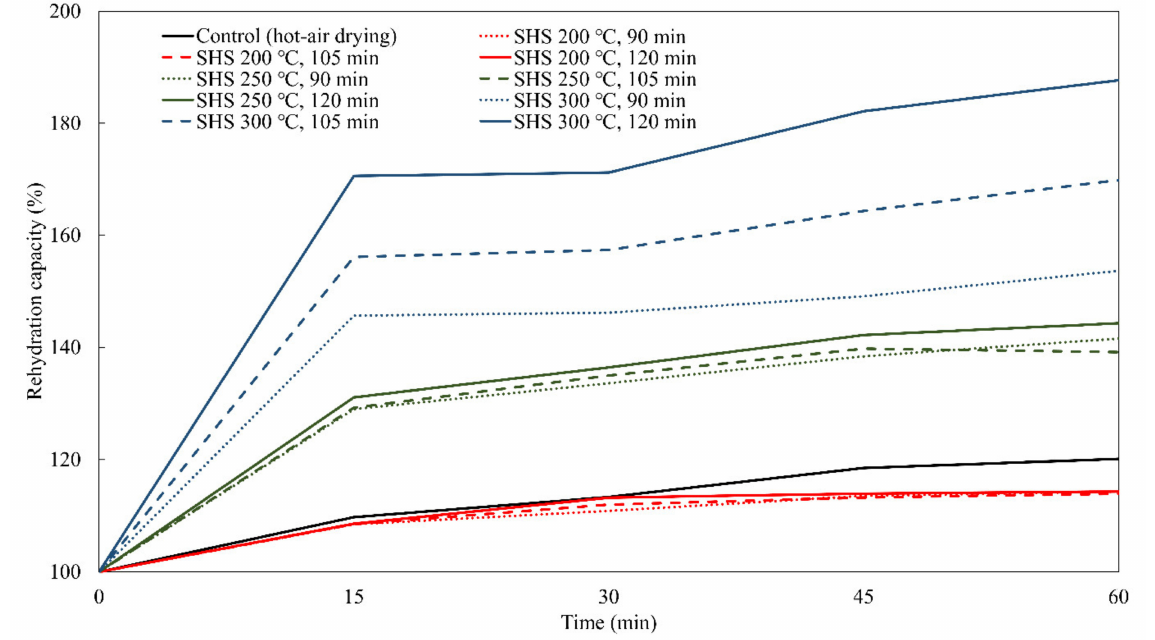
Figure 2. Rehydration capacity of semi-dried restructured jerky processed with super-heated steam